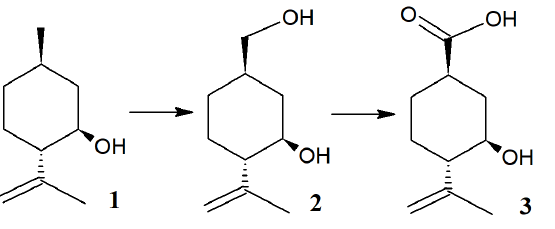
Figure 11. Proposed pathway of (‒) -isopulegol bioconversion by R . rhodochrous IEGM 1362.